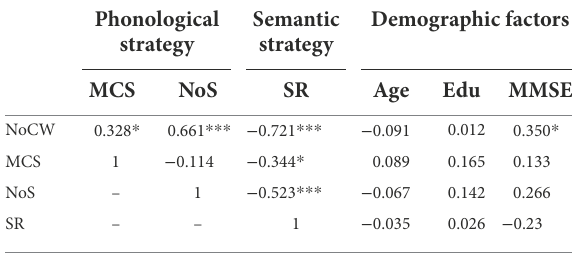
TABLE 2 Results of Pearson correlation